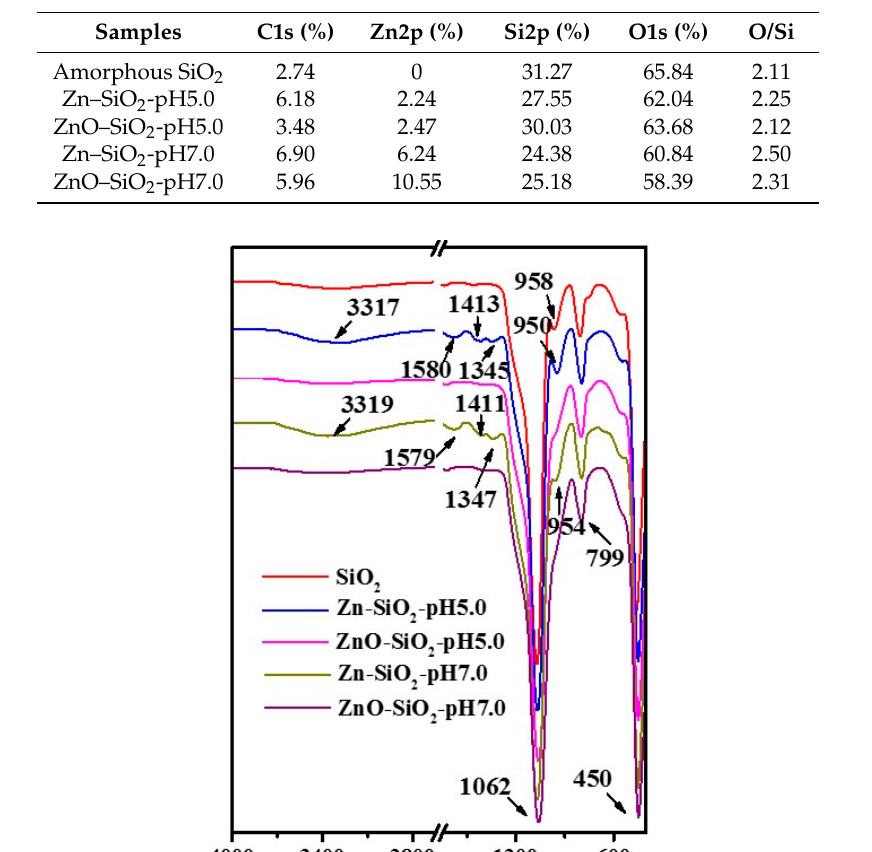
Figure 6. XPS of ( a ) ZnO–SiO 2 -pH5.0; ( b ) ZnO–SiO 2 -pH7.0. Table 2. Element analysis based on XPS results